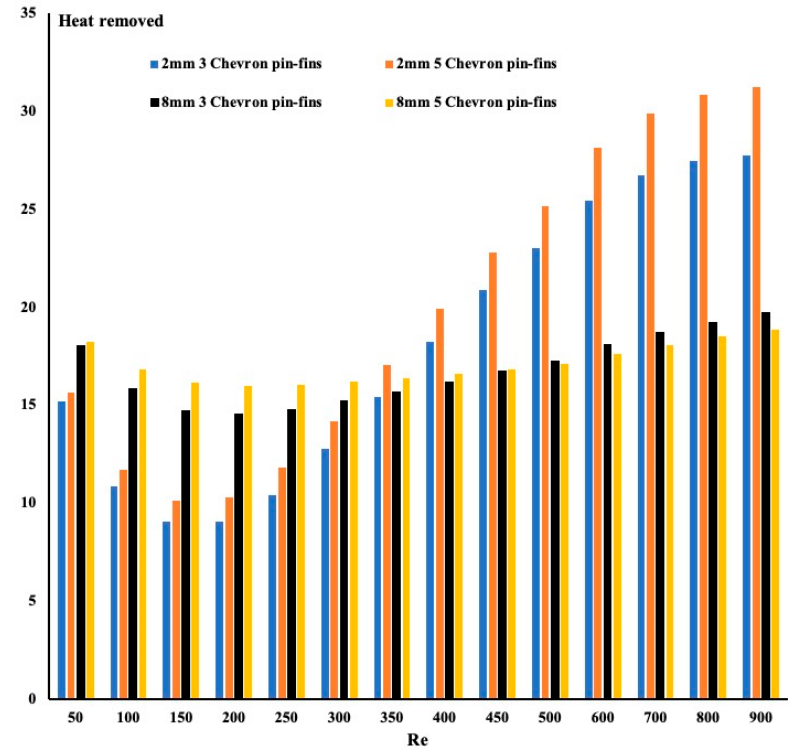
Figure 6. Heat removed using solid pin-fins.